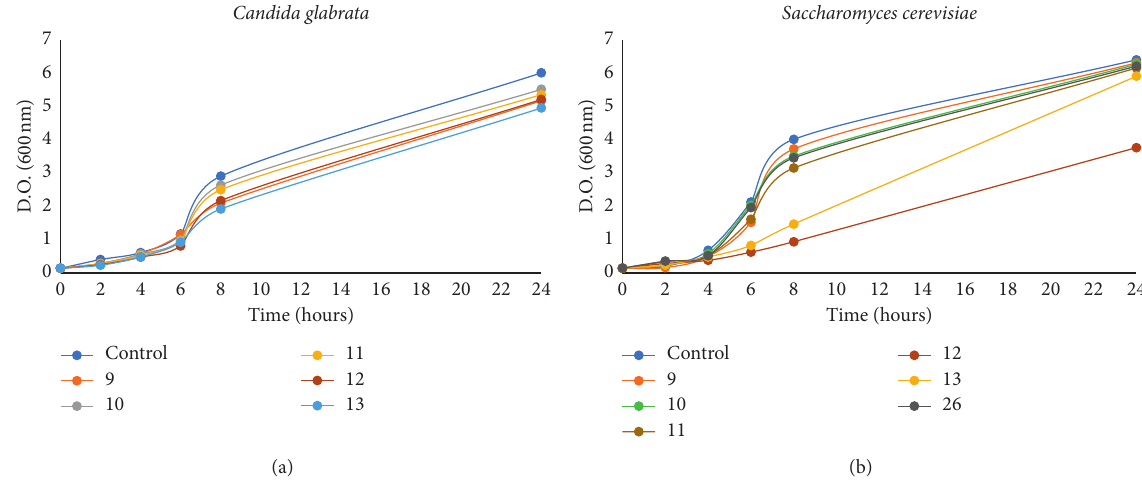
Figure 5: Activity of mono- and tetradentate pyrazole ligands against Candida glabrata and Saccharomyces cerevisiae . Cells were cultured in the absence (“no drug” control) or in the presence of 500 µ M of compounds 9 – 13